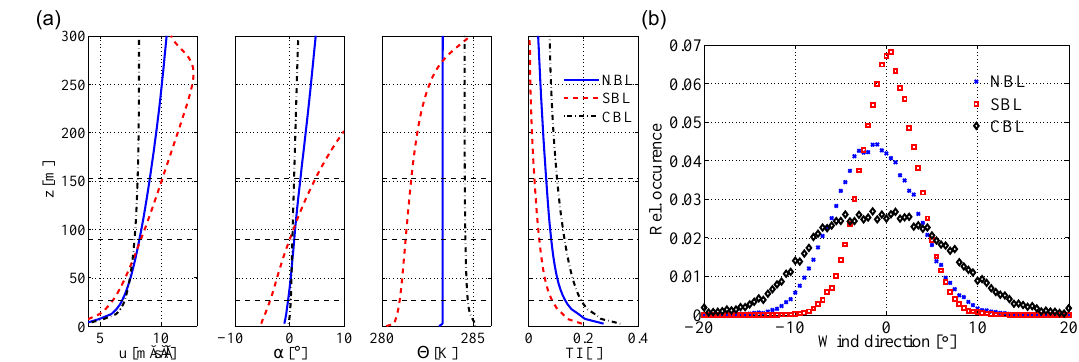
Figure 3. Flow statistics during the last hour of the precursor simulations. (a) Horizontally averaged vertical profiles of wind speed, flow direction, potential temperature and turbulence intensity. Horizontal lines denote the height of the blade tips and the hub. (b) Distribution of the 1Hz wind direction from point measurements at hub height.